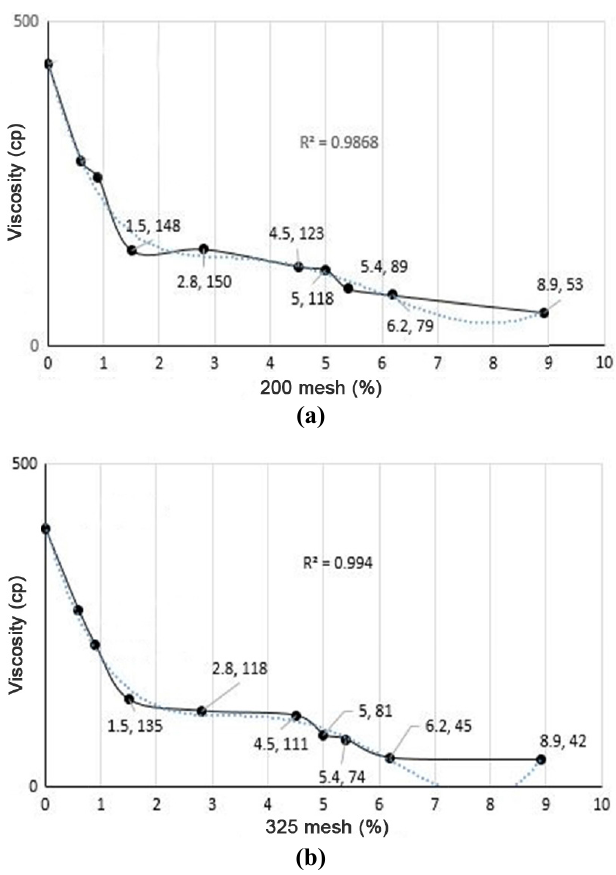
Fig. 3. The effect of grains on specific gravity of (a) 200 mesh